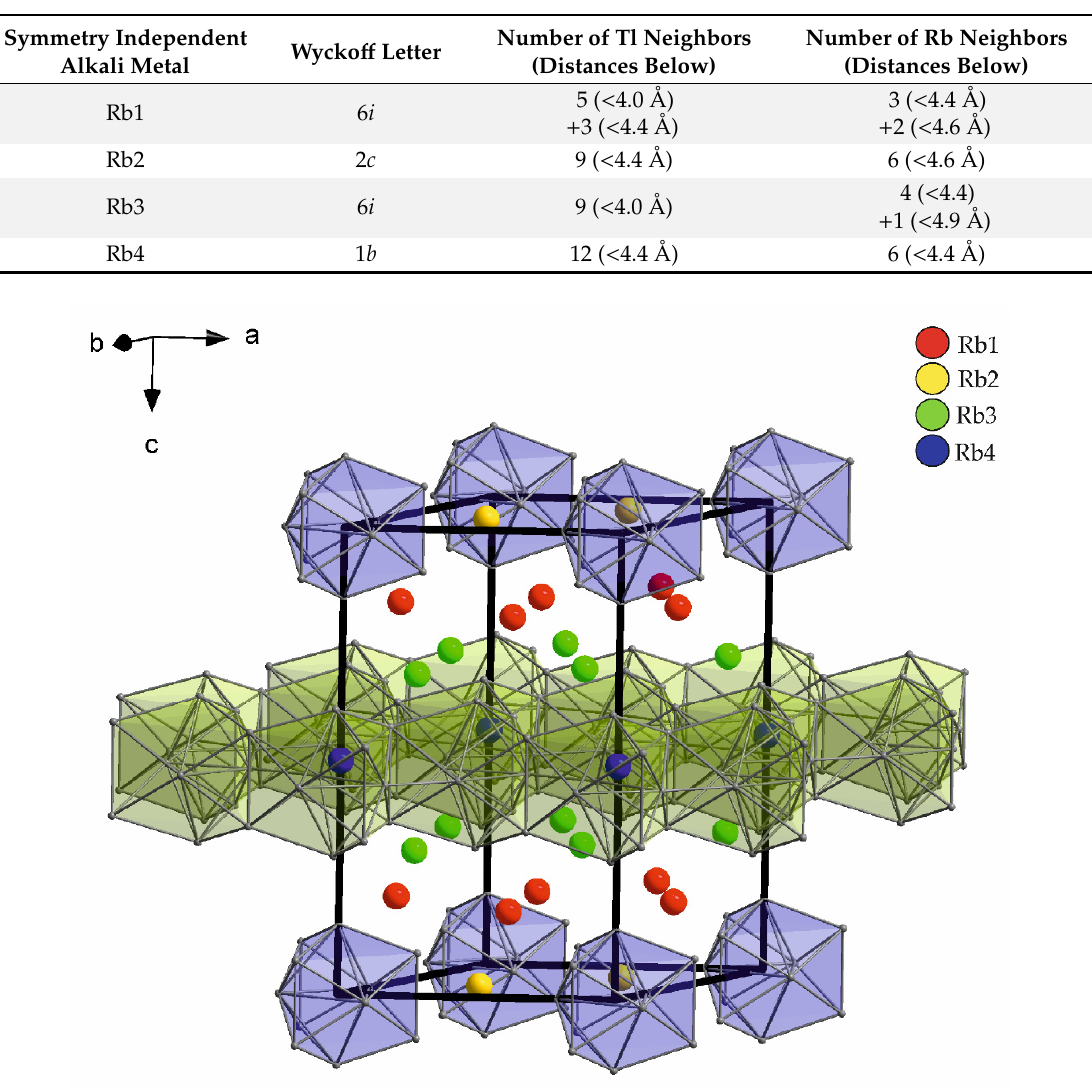
Figure 6. Four symmetry inequivalent Rb positions in Rb 15 Tl 27 . Rb2 connects the Tl 117 − clusters, Rb4 is situated within the Tl layers formed by condensed Tl 11 subunits. Rb1 and Rb3 are located between the two different Tl